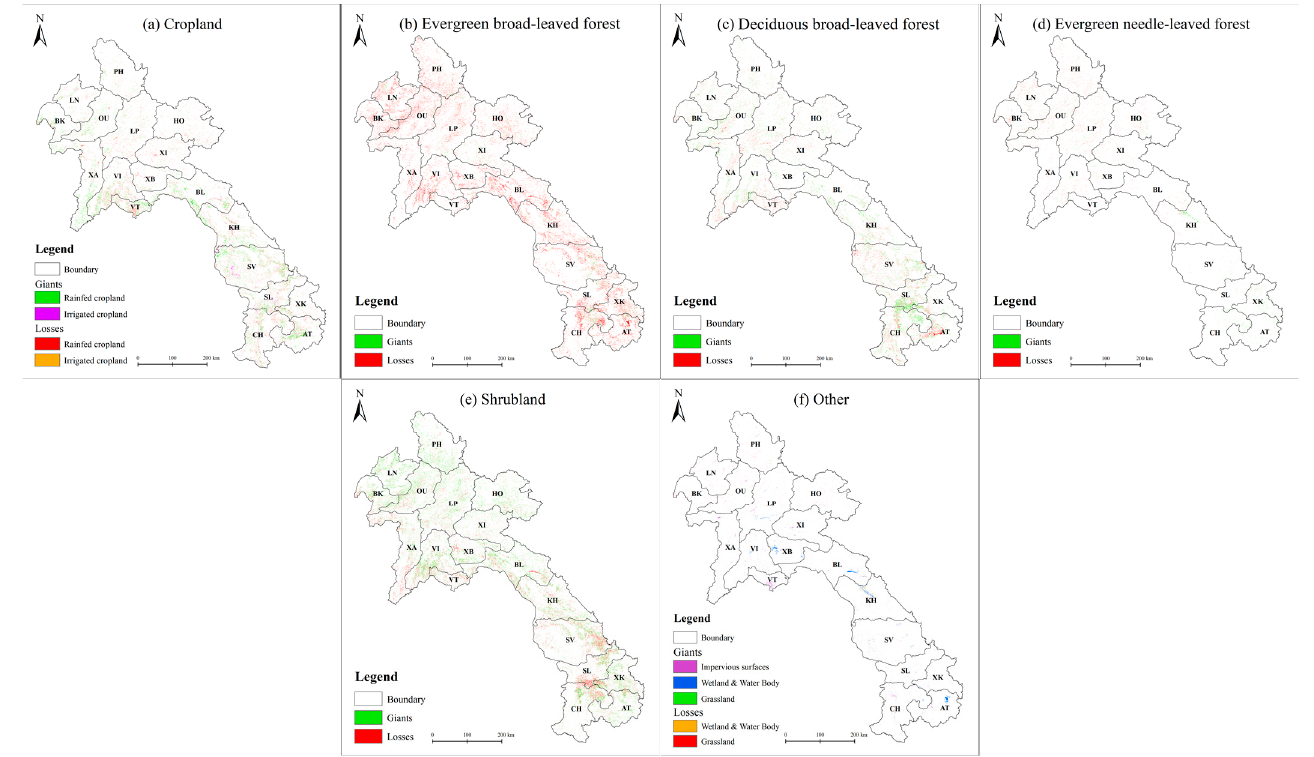
Figure 6. Spatial distributions of different LUC types gains/losses during 2000–2020. Evergreen broad-leaved forest is the land type with the widest coverage in Laos and the largest transferred area. The total lost area of evergreen broad-leaved forest was 8.91 × 10 3 km 2 , nearly 65% of which was converted into shrubland, nearly 27% was converted into rainfed cropland and deciduous broad-leaved forest, and a few were converted into evergreen needle-leaved forest and wetlands and water body. Meanwhile, evergreen broad-leaved forest gained an area of 1.32 × 10 3 km 2 , of which about 57% came from shrubland, and about 40% came from rainfed cropland, deciduous broad-leaved forest, and evergreen needle-leaved forest. Evergreen broad-leaved forest is the land type with the most severe area reduction in the territory. The lost area of evergreen broad-leaved forest of all provinces was larger than the gained area. The country showed a trend of sharp reduction in evergreen broad-leaved forest, with the largest reduction in the municipality of Vientiane ( − 29.4%) (Figure 6b). The lost area of deciduous broad-leaved forest was 2.38 × 10 3 km 2 , 51% of which was converted to rainfed cropland, 35% to shrubland, and a few were converted to other LUC types. The deciduous broad-leaved forest gained area of 3.53 × 10 3 km 2 , and nearly 95% came from the evergreen broad-leaved forest, shrubland, and rainfed cropland. The deciduous broad-leaved forest showed an overall expansion trend, with the most obvious expansion in Borikhamxay (+21%). Within the territory, only Attapeu ( − 5.4%)